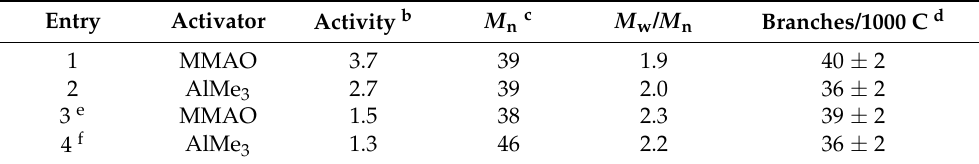
Table 1. Ethylene polymerization data for the catalyst systems L 2 Ni II Br 2 /MMAO and L 2 Ni II Br 2 /AlMe 3 a .